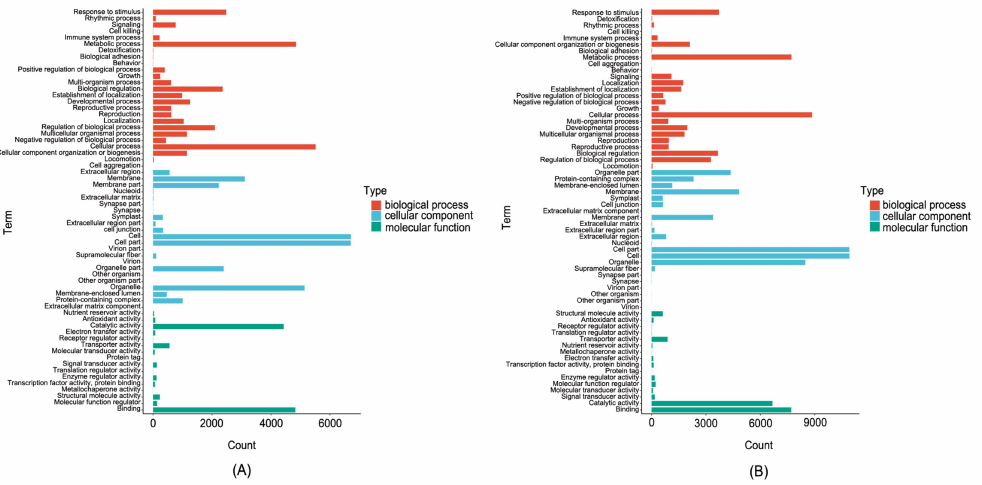
Figure 8. GO categories of the predicted target genes of the DEGs in ginseng leaves ( A ) and stems ( B ).